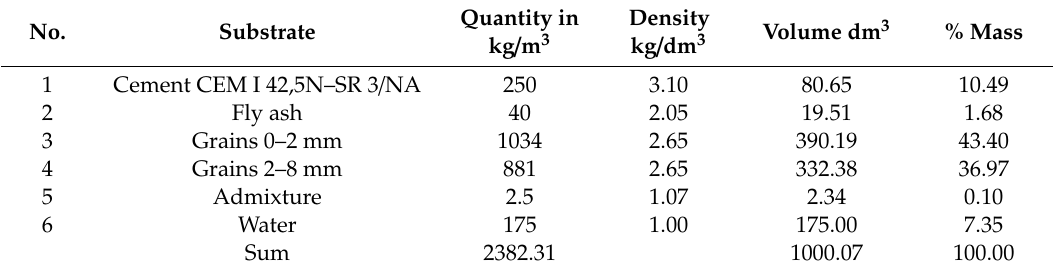
Table 5. Composition of the control mixture.